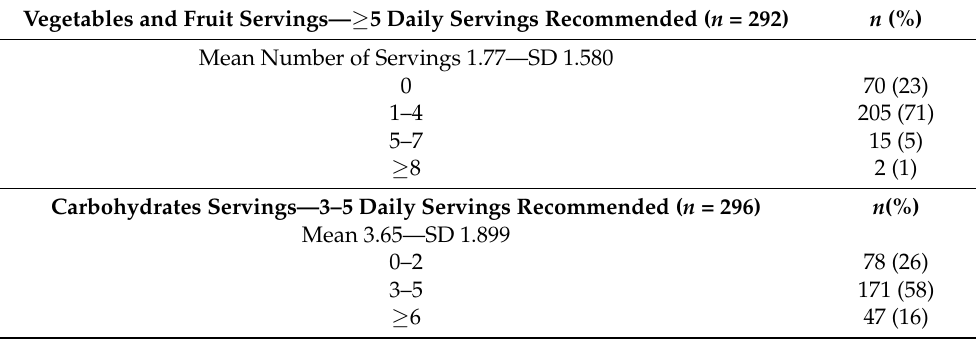
Table 3. Daily Intake of Food Groups Compared to the Healthy Food for Life Guidelines. Vegetables and Fruit Servings— ≥ 5 Daily Servings Recommended ( n =